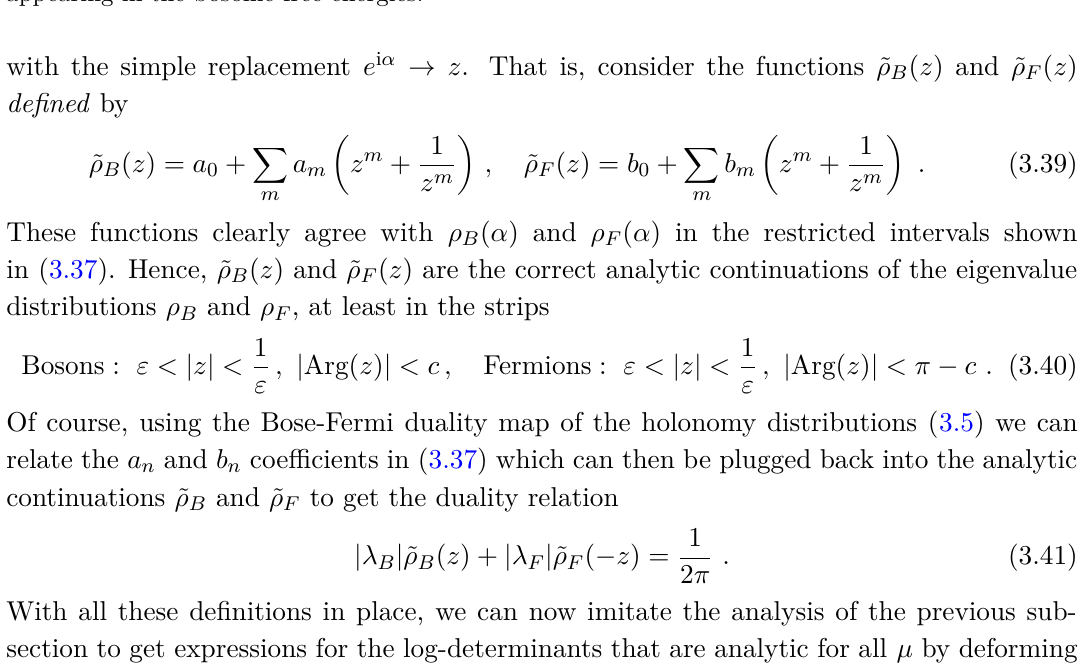
Figure 8 . Bosons in non-upper cap phases: the branch point is at z = + e ˆ (cid:15) −| ˆ µ | and is denoted by the black dot on the +ve real axis. The orange curve is the contour (counterclockwise) over which the holonomy is integrated over in this phase. The red line is the branch cut for the logarithm appearing in the bosonic free